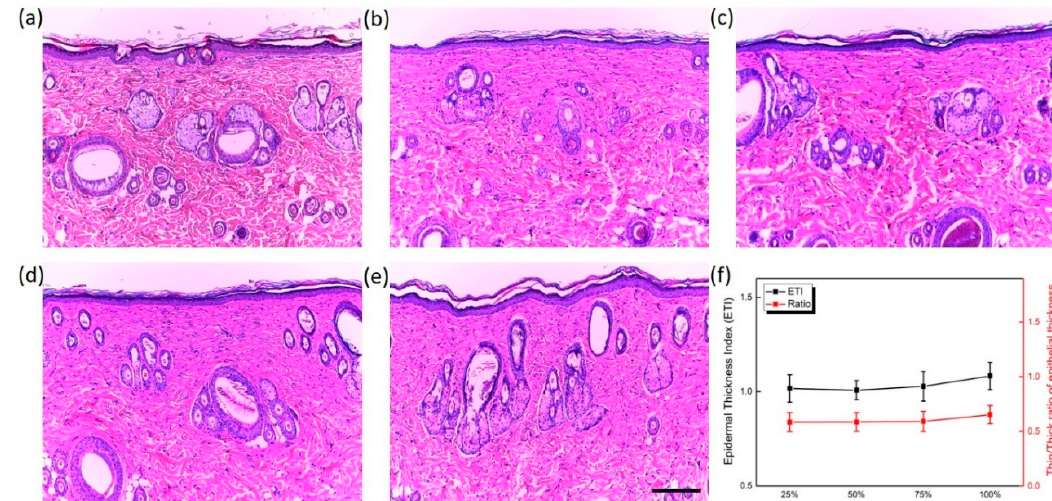
Figure 6. Hematoxylin and eosin (HE) staining images acquired after six laser treatments for various concentrations (week 6; scale bar = 200 μ m): ( a ) normal tissue (non-injected and non-treated), ( b ) 25%, ( c ) 50%, ( d ) 75%, ( e ) 100%, and ( f ) quantitative comparison of epidermal thickness index (ETI) and thin/thick ratio in epidermis (10 measurements per concentration).